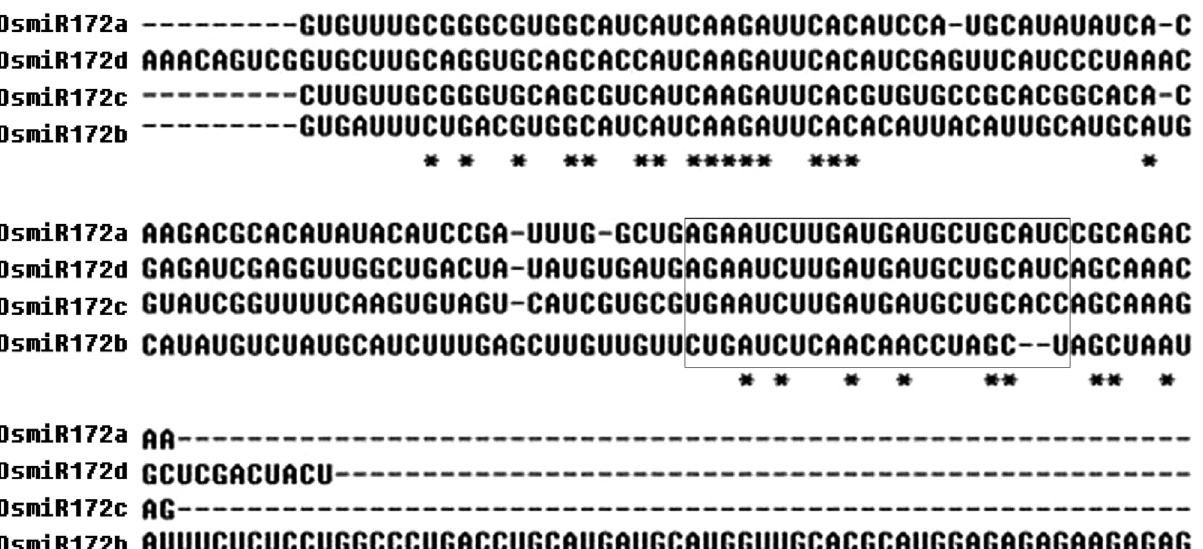
Figure 1 - Sequence alignment of rice miR172 s. *Conserved nucleotides. The core region is